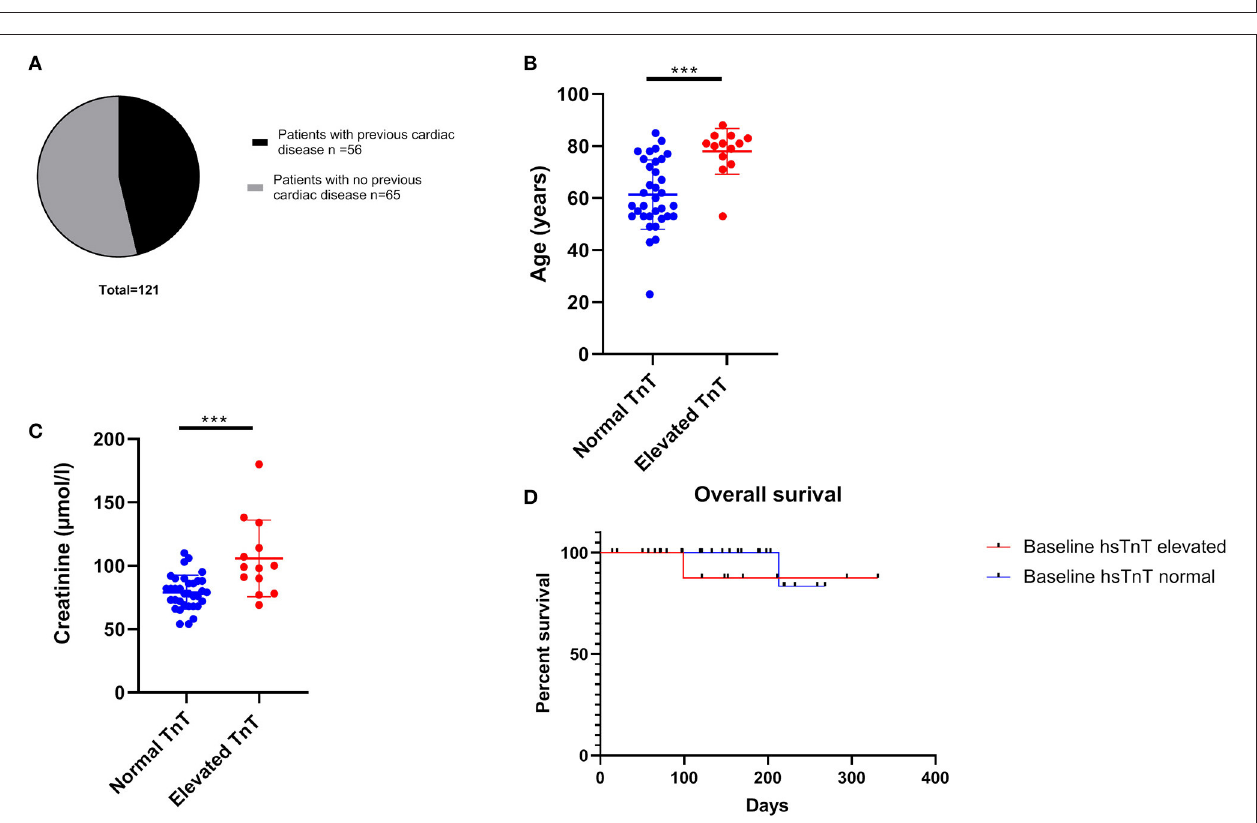
FIGURE 2 | Cardiac magnetic resonance imaging of a patient with irM following a single infusion of cemiplimab. Cardiac MR revealed focal subepicardial to mid myocardial delayed gadolinium enhancement (A–C) associated with edema (D–F) at the lateral and inferoseptal apex (asterisks) involving the pericardium (arrows) in a delayed gadolinium enhancement sequence performed according to clinical standard. PSIR, phase-sensitive inversion recovery; STIR, short tau inversion recovery; SAX, short-axis view; 4ch, 4-chamber view; 2ch, 2-chamber view.